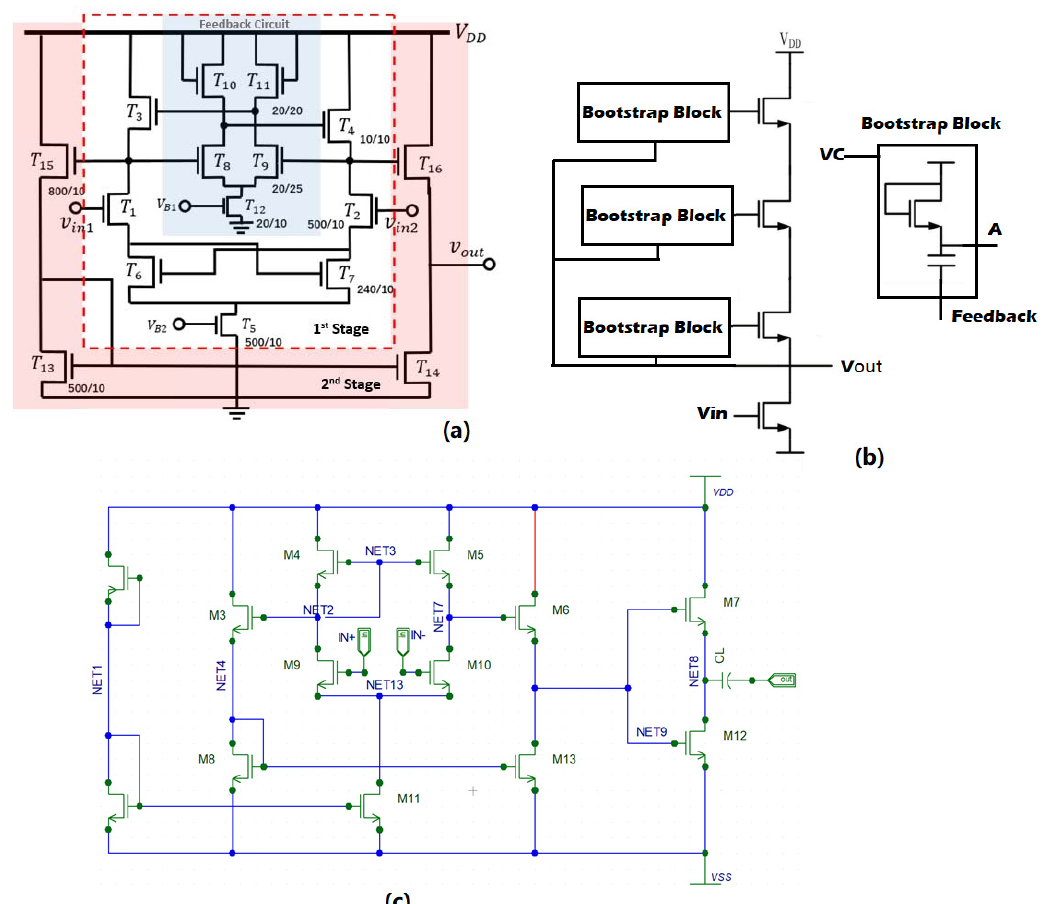
Figure 14. Amplifier of oxide-based TFT: ( a ) Transconductance-enhancement amplifier [157] (Reprinted with permission from ref. [157]. Copyright 2022 IEEE) and ( b ) Low noise amplifier. ( c ) LTPO amplifier.